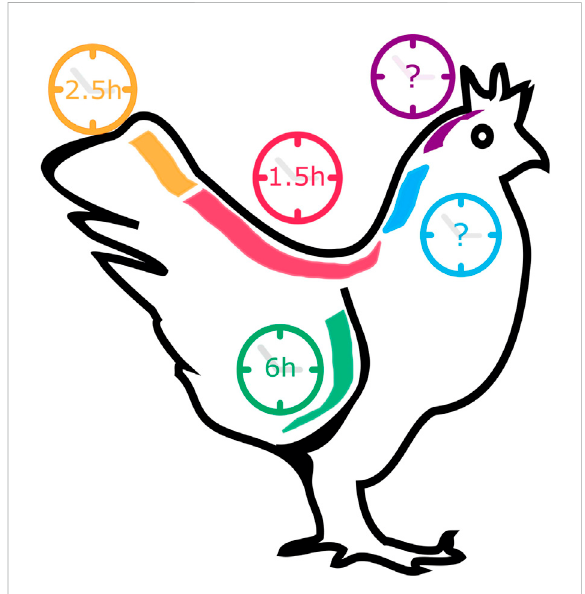
FIGURE 3 The pace of Gallus gallus Embryo Clock (EC) oscillations in different tissues. During somitogenesis (red and orange), the EC pace ranges from 1.5 to 2.5 h, while during forelimb development (green) a cycle lasts 6 h. EC dynamics in the early stages of somitogenesis (blue) and in neural development (purple) remain